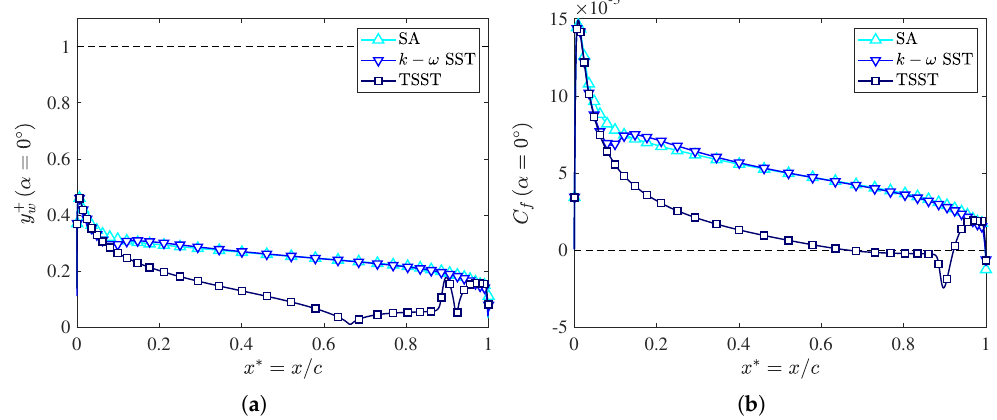
Figure 8. Wall y + and friction coefficient trends as a function of the turbulence model obtained with the finest grid. ( a ) y + w distribution on the airfoil surface; ( b ) C f distribution on the airfoil surface.